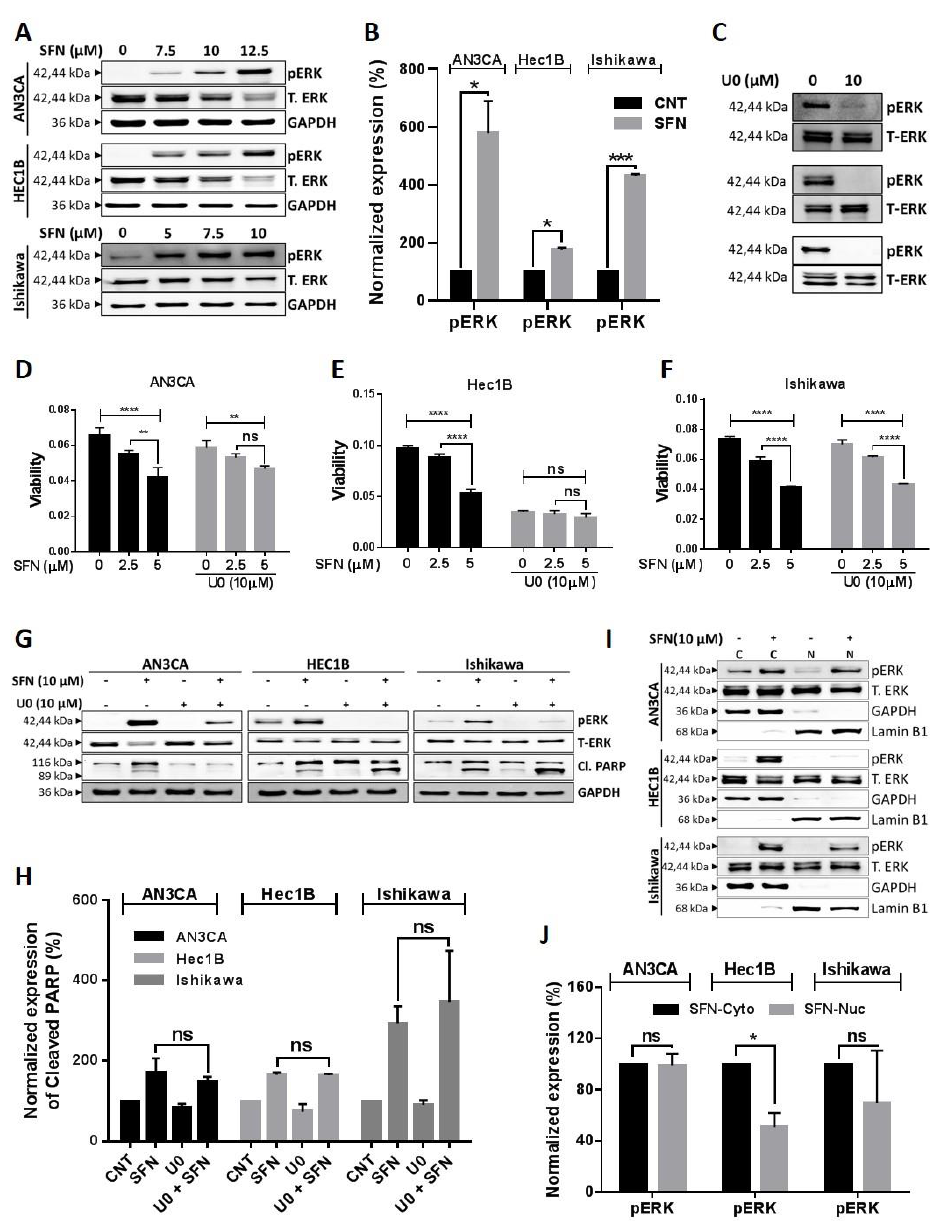
Figure 5. Sulforaphane induces phosphorylation of ERK / MEK and its cytoplasmic retention. ( A , B ) Endometrial cancer cells were treated with sulforaphane for 24 h and cell lysates were analyzed by western blot with antibodies against MEK-ERK signaling. GAPDH was used as a reference gene. Representative blots are shown ( A ) and densitometric quantitation of protein expression levels are shown as fold changes with ± SE and t -test was used for statistical analysis. ( C ) Endometrial cancer cells were treated with ERK inhibitor (U0) at indicated concentration for 4 h, and knockdown of pERK was confirmed by western blot analysis. Total ERK was used as a reference gene. Representative blots are shown. ( D – F) Endometrial cancer cells were pretreated with U0 or vehicle for 4 h prior to addition of sulforaphane for 24 h, and cell viability was analyzed by MTT. Cell viability (optical density) are shown as mean ± SD and a Two-way ANOVA was used for statistical analysis. ( G , H ) Endometrial cancer cells were pretreated with indicated concentration of U0 or vehicle for 4 h before the treatment of sulforaphane for 24 h, and proteins were isolated. Expression of pERK, total ERK, and cleavage of PARP as an apoptosis marker were analyzed by western blot. GAPDH was used as a loading control. Representative blots are shown ( G ), densitometric quantitation of protein expression levels are shown as fold changes with ± SE, and t -test was used for statistical analysis of sulforaphane alone vs sulforaphane with pretreated U0 ( H ). ( I – J ) Cytoplasmic vs nuclear subcellular fractions were